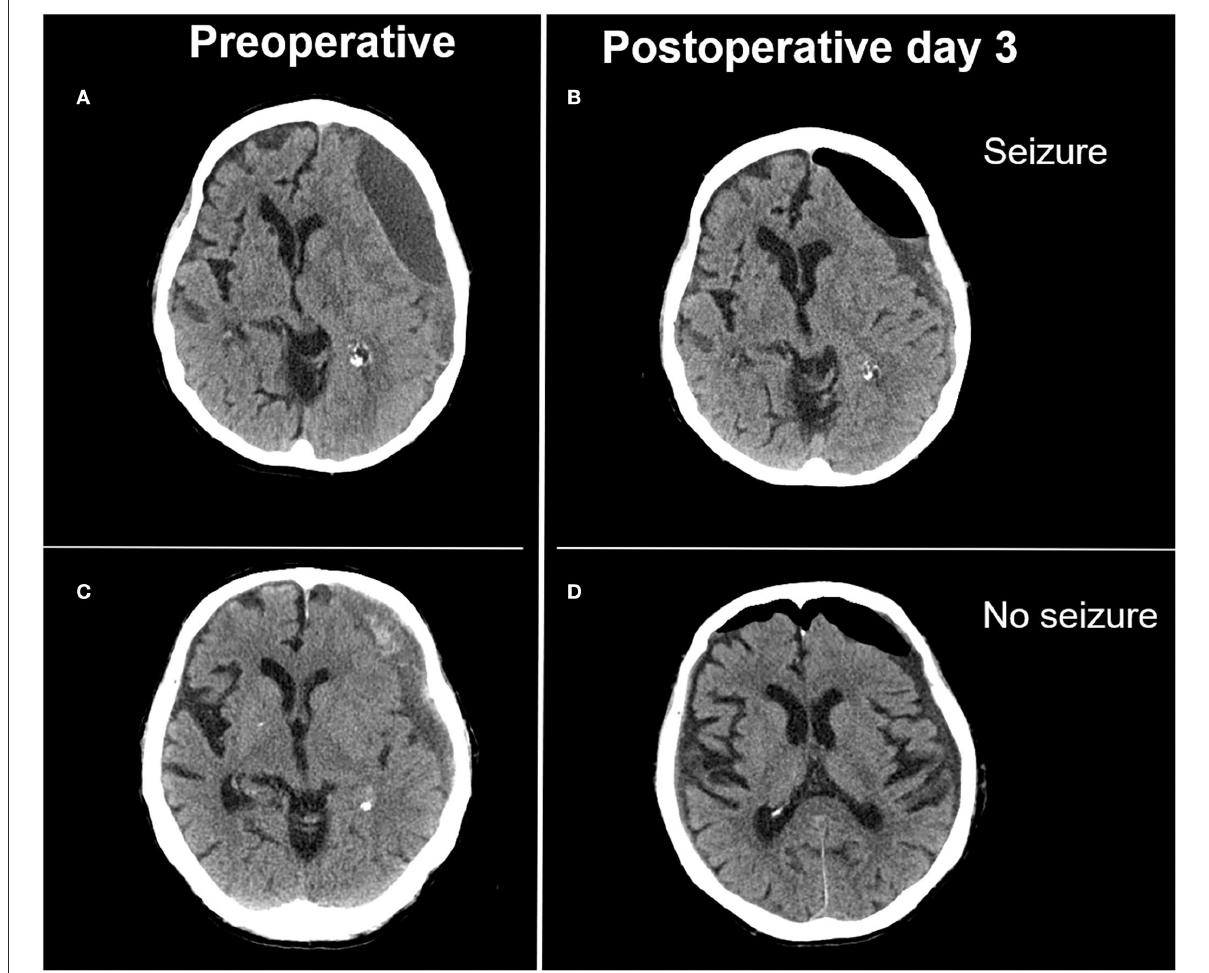
FIGURE2 Illustrative case of extensive depressed brain volume leading to postoperative seizure and adequate postoperative brain expansion not associated with postoperative seizure. (A) Preoperative image of a laminar type hematoma demonstrating limited brain re-expansion (B)